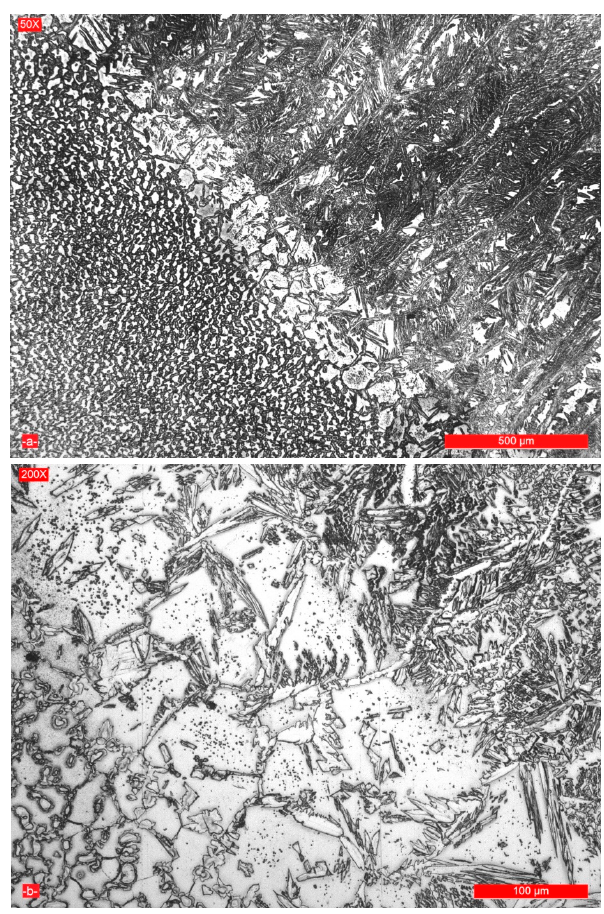
Figure 8. Microstructure of the weld-HAZ interface for achieving the welded joint with a linear energy. E l = 15 kJ/cm: ( a ) magnification 50×; and ( b ) magnification 200×.